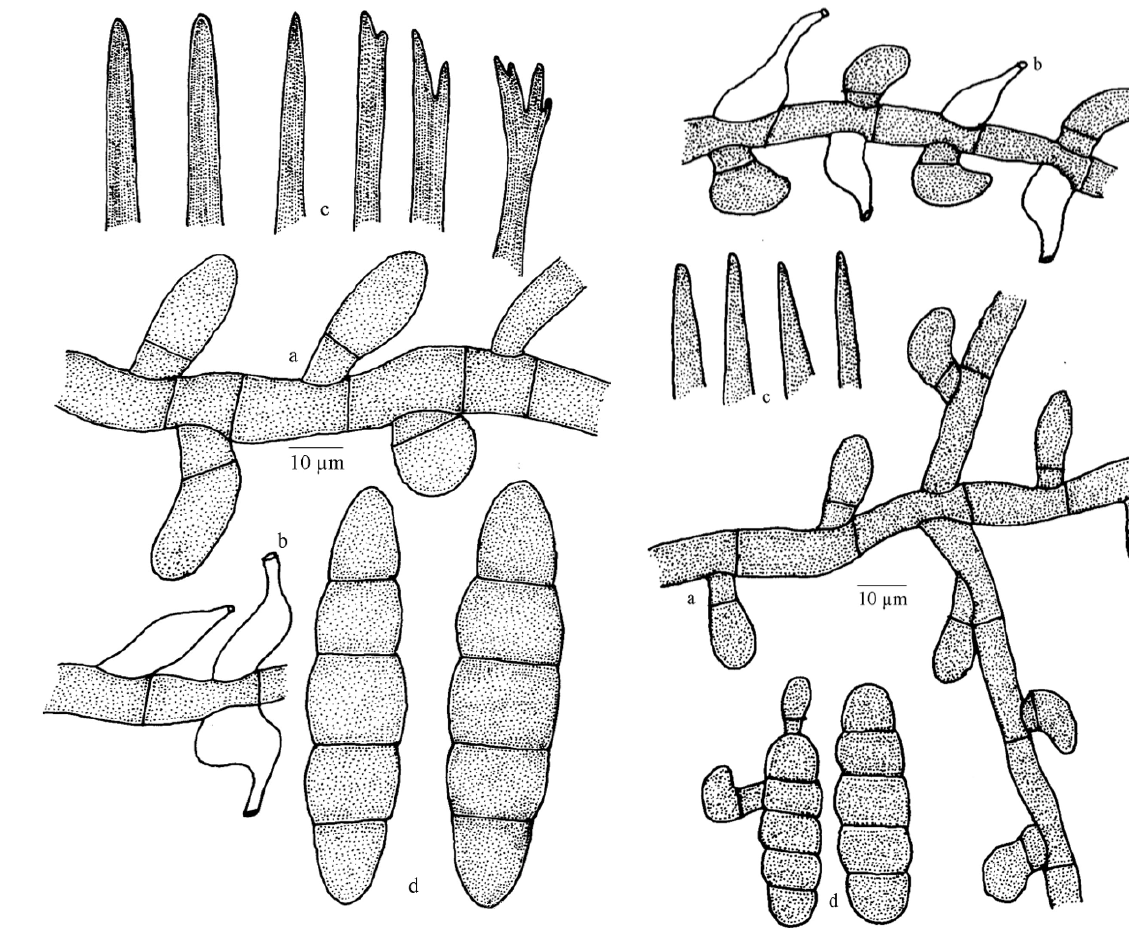
Figure 49. Meliola beilschmiediae var . cinnamomicola a - Appressorium; b - Phialide; c - Apical portion of mycelial setae; d - Ascospores